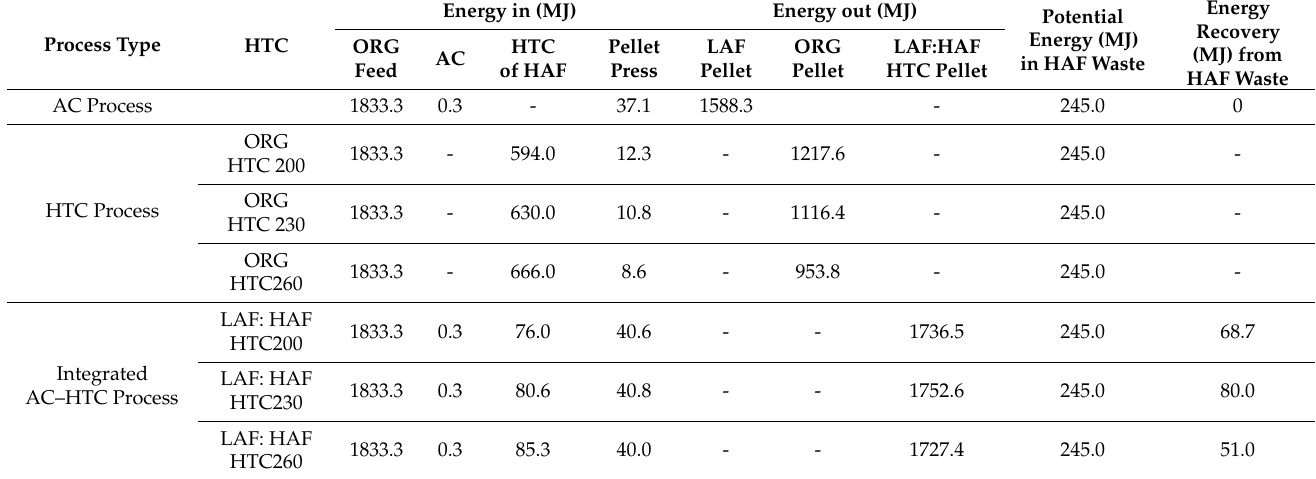
Table 4. Energy extracted from HAF